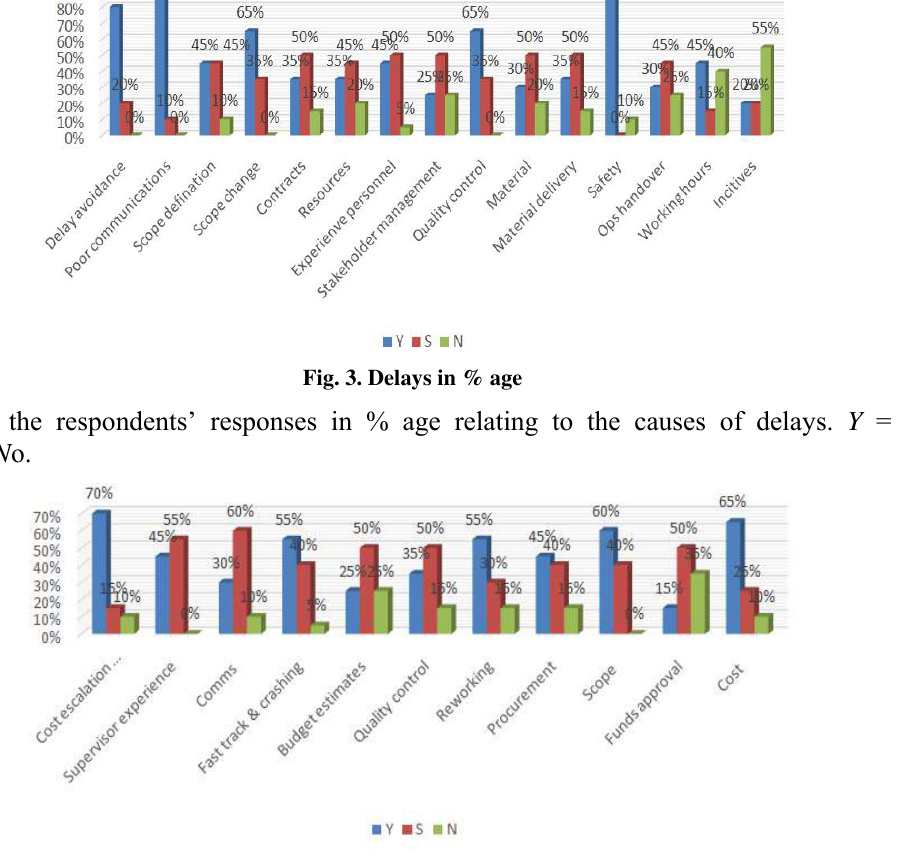
Fig. 4. Cost escalation in % age